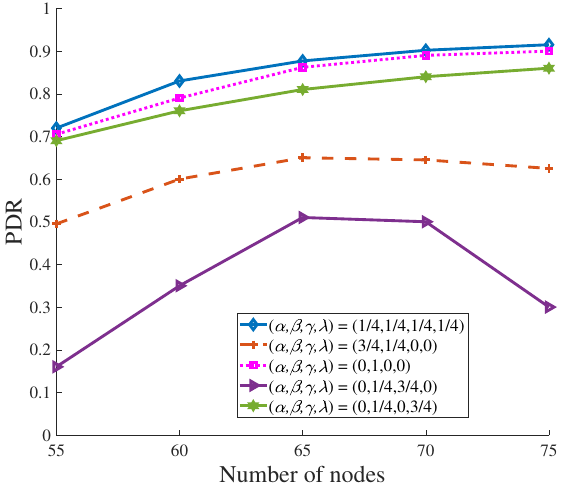
Figure 7. PDR of CLIC.